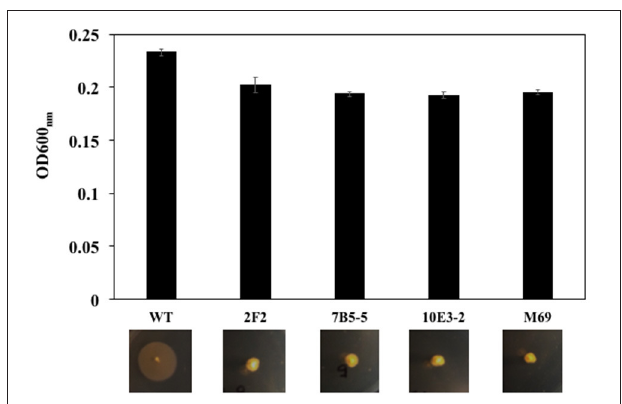
FIGURE 5 | Comparation of the cell growth in PY2 broth and gliding motility on the PY2 agar between the WT and mutants. Transposon pHimarEm1 was introduced into F. spartansii T16 T and erythromycin-resistant conjugants were sub-cultured in PY2 broth. The cell growth was compared by determining the OD600nm after overnight culture (up panel). The motility was evaluated by culture the cells on PY2 agar after 48h (low